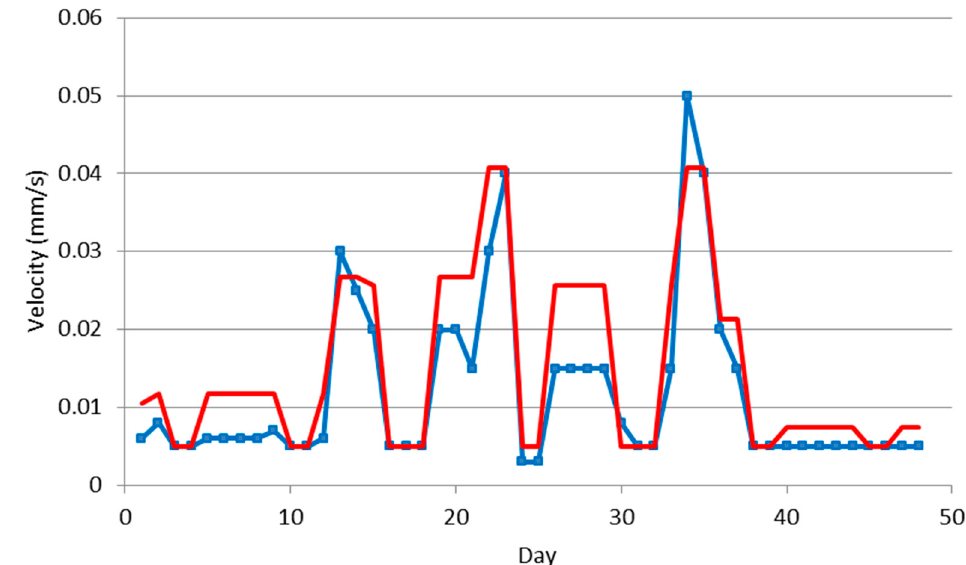
Figure 11. Maximum filtered daily velocities, in blue, and estimated values using Equations (3)–(5), in red.